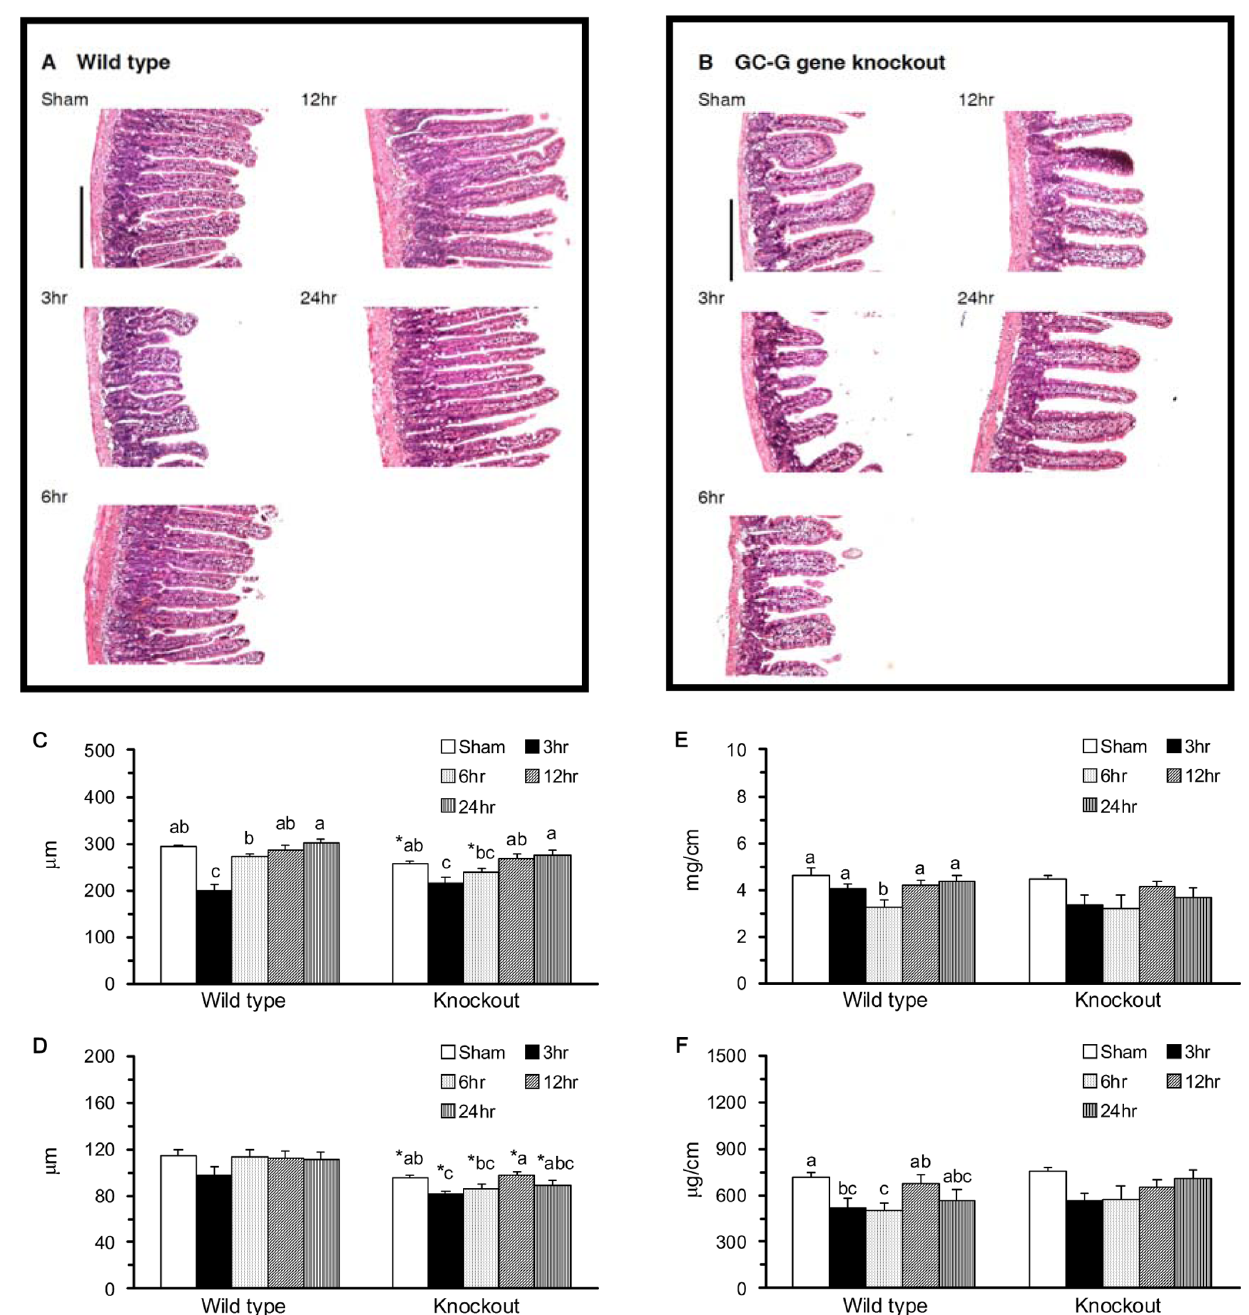
Figure 1. Jejunal morphology. H&E staining in WT (A) and KO (B) mice. Scale bars =25 m m. The average villus height (C), crypt depth (D), and mucosal dry weight (E) and protein content (F) per centimeter of jejunum. Means 6 SEM, n=10 for WT groups and n=9 for KO groups. *P , .05, KO vs. WT mice with sham operation or with intestinal IR at the same time point (Student’s t-test,). Values with different superscripts indicate significant differences within all of the time points in WT and KO mice, individually (one-way ANOVA with LSD, P , .05). ATG GGC TTC CC-3 9 . The relative expression ratio of the mGC-G transcript to the GAPDH transcript was calculated.